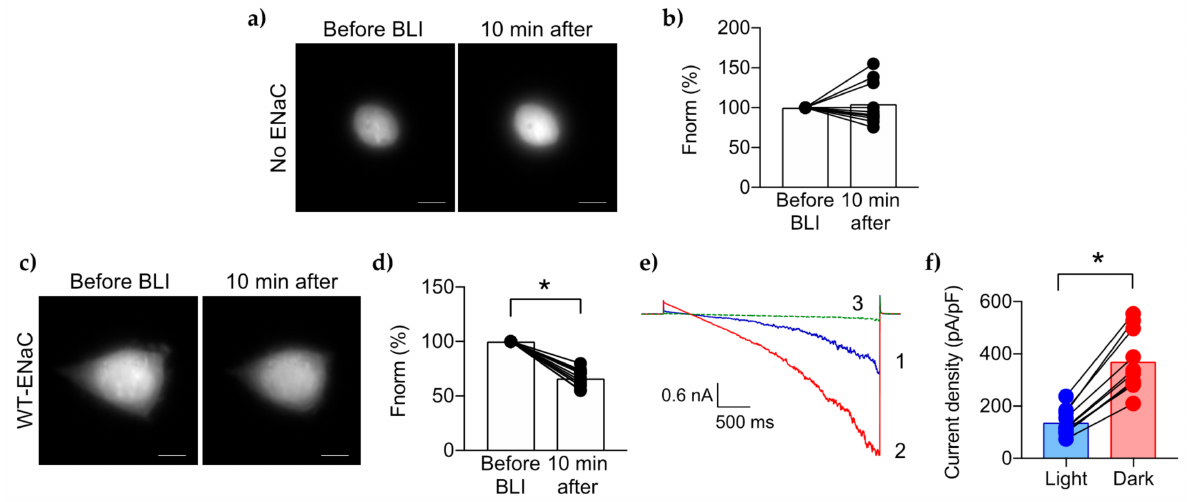
Figure 2. PIP2 depletion decreases [Na + ] i and current density of wtENaC. Representative micro- graphs show the CoroNa Green uptake in HEK 293 cells without transfection ( a ) or transfected with wtENaC ( c ). Summary graphs of changes in the mean [Na + ] i of cells with no ENaC (n = 11 cells) ( b ) or wtENaC (n = 11) ( d ), as measured by CoroNa intensity excited at 514 nm, 10 min after BLI, normalized to CoroNa levels before BLI. ( e ) Representative current trace showing wtENaC activity under BLI (1, blue trace), followed by Dark (2, red trace), and finally with application of 10 µ M amiloride (3, green trace). ( f ) Summary graph of the mean current density of wtENaC at − 100 mV under low PIP2 levels (Light, blue bar and blue circles) vs. maximum PIP2 levels after 10 min (Dark, red bar and blue circles) (n = 10). For each graph, the line drawn between 2 circles represents an independent cell under different PIP2 levels. * Indicates p < 0.0001 determined by the paired t